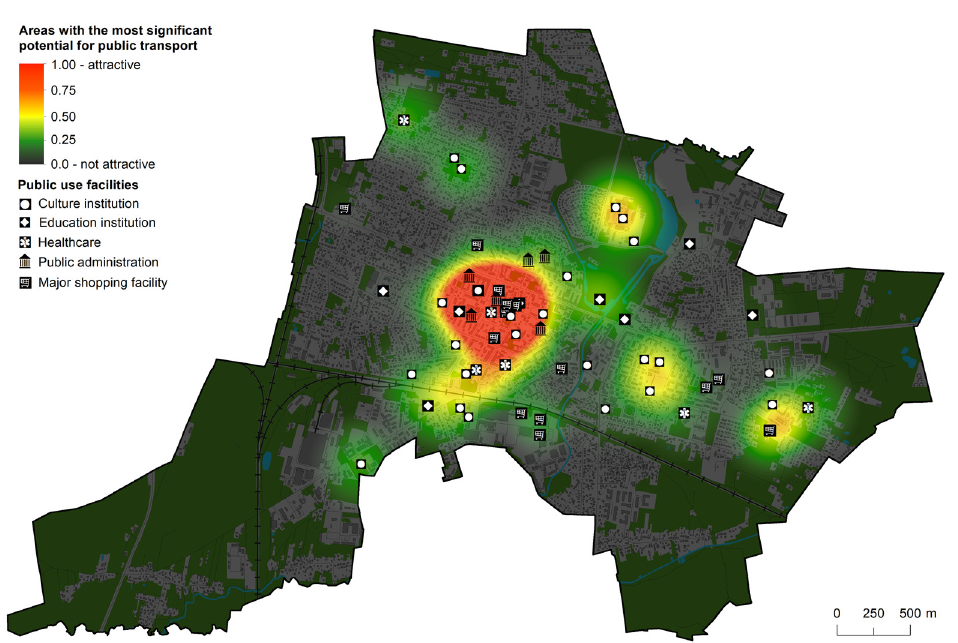
Fig. 4. Areas with the most significant potential for public transport in means of public use